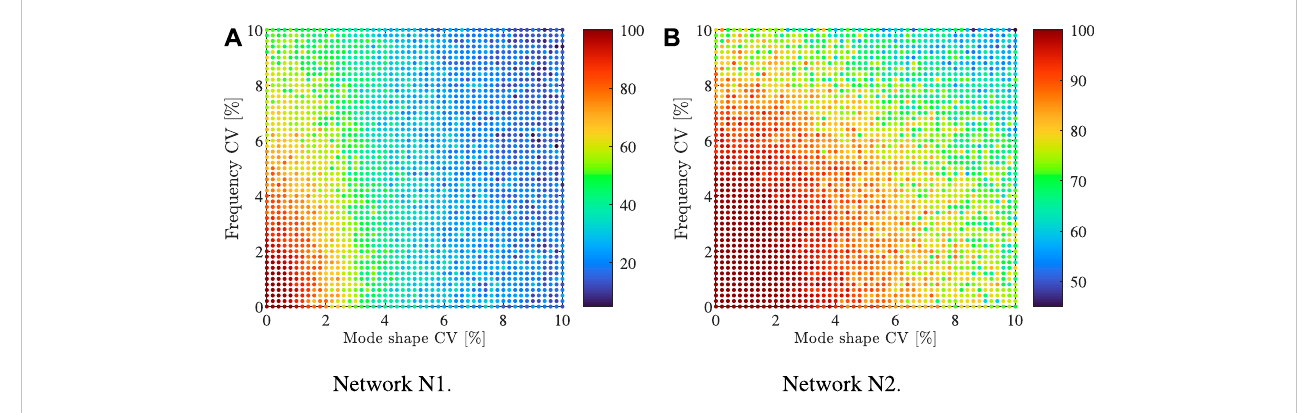
FIGURE 7 Numerical case study: plot of the accuracy of the network (A) N1 and (B) N2 for different values of the frequency and mode shape coef fi cient of variation